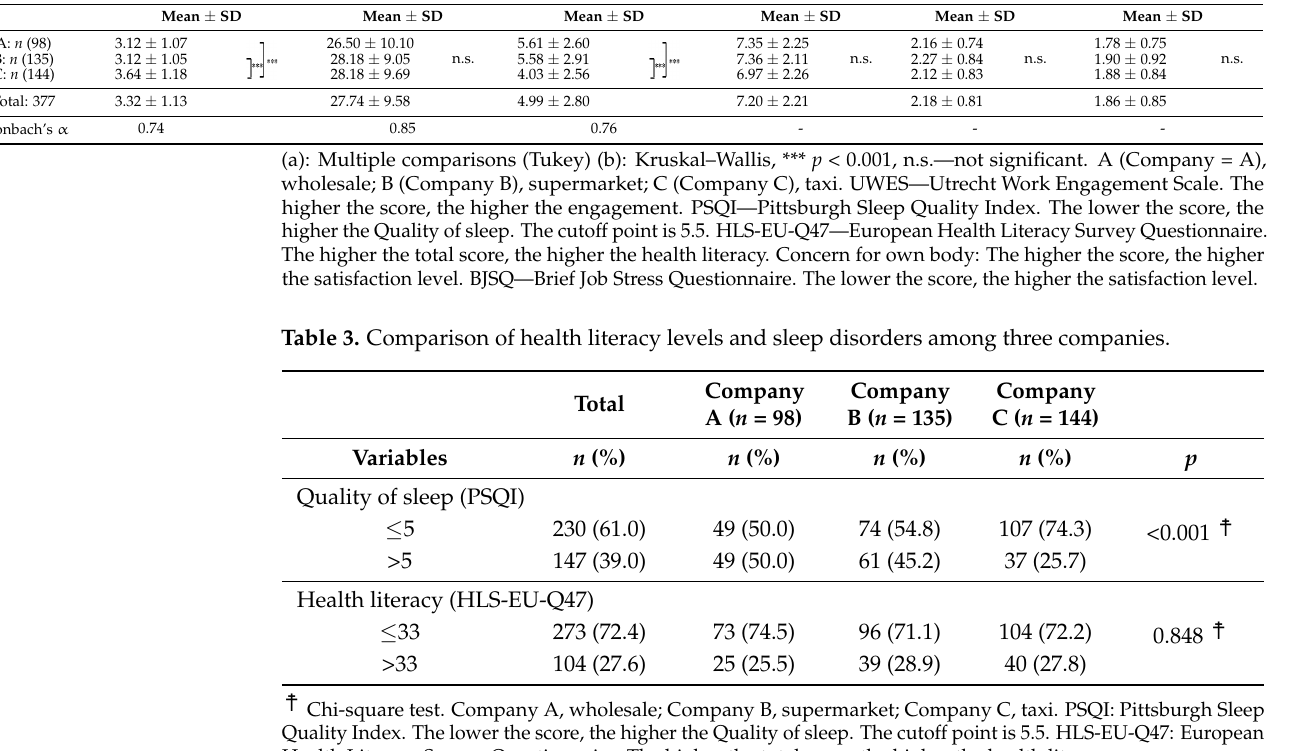
3.2. Multiple Regression Analysis with WE as a Dependent Variable Table 4 shows the result of multiple regression analysis (stepwise method) for WE measured by UWES as a dependent variable. Those showing significant associations were job satisfaction ( β = −0 .38, p < 0.001), age ( β = 0.28, p < 0.001), HL ( β = 0.14, p < 0.001), and quality of sleep ( β = −0 .11, p = 0.01). The results showed that higher job satisfaction, higher age, higher HL, and a better quality of sleep contributed to WE. Table 4. Stepwise multiple regression analysis for Work Engagement. Table 4. Stepwise multiple regression analysis for Work Engagement.